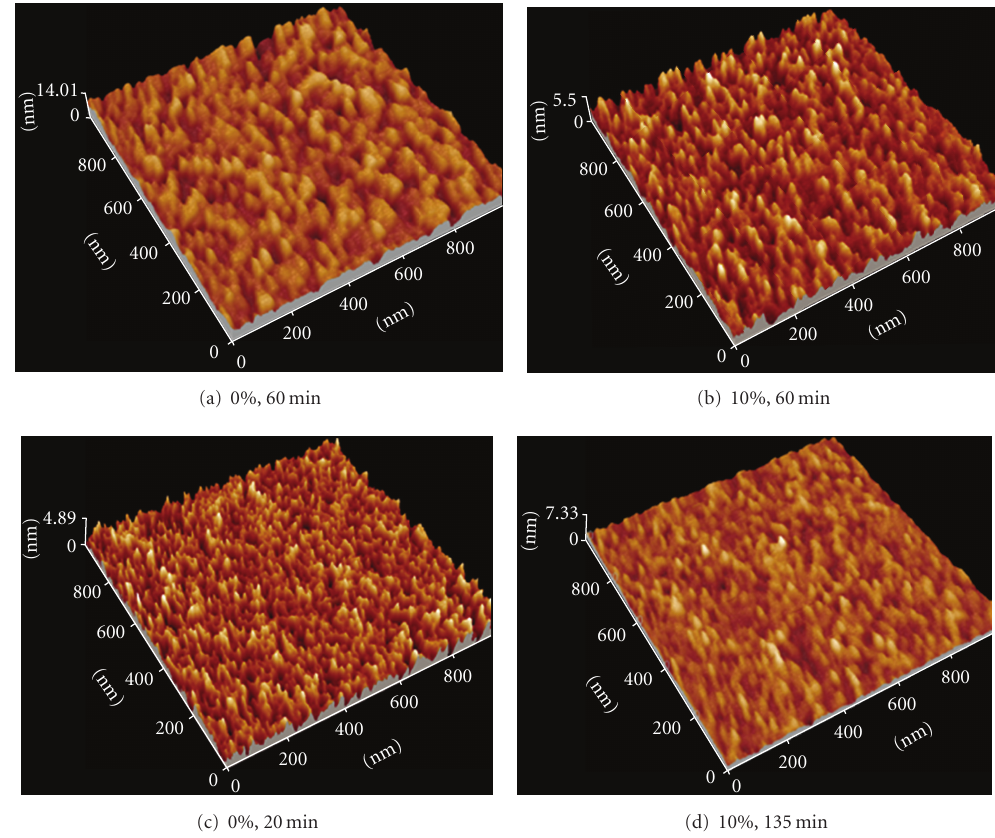
Figure 2: AFM images of samples of di ff erent oxygen pressure percentage and deposition time.